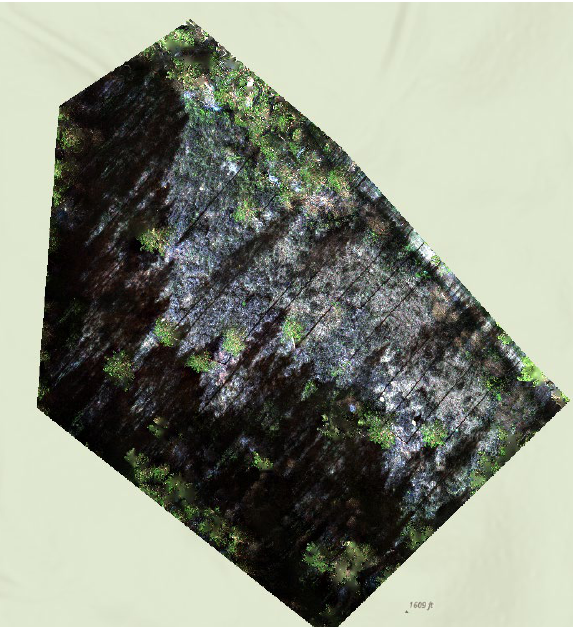
Figure 7: Orthomosiac generated at 6.08 cm/pixel